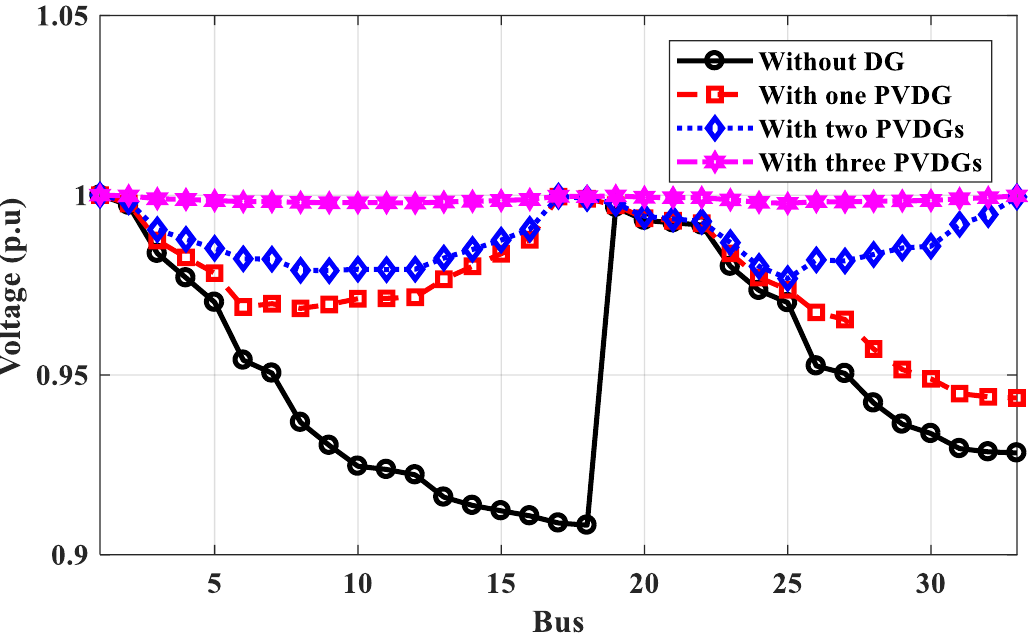
Figure 14. Voltage profile of IEEE 33-bus without and with PV system DGs for annual energy loss Figure 14. calculation.